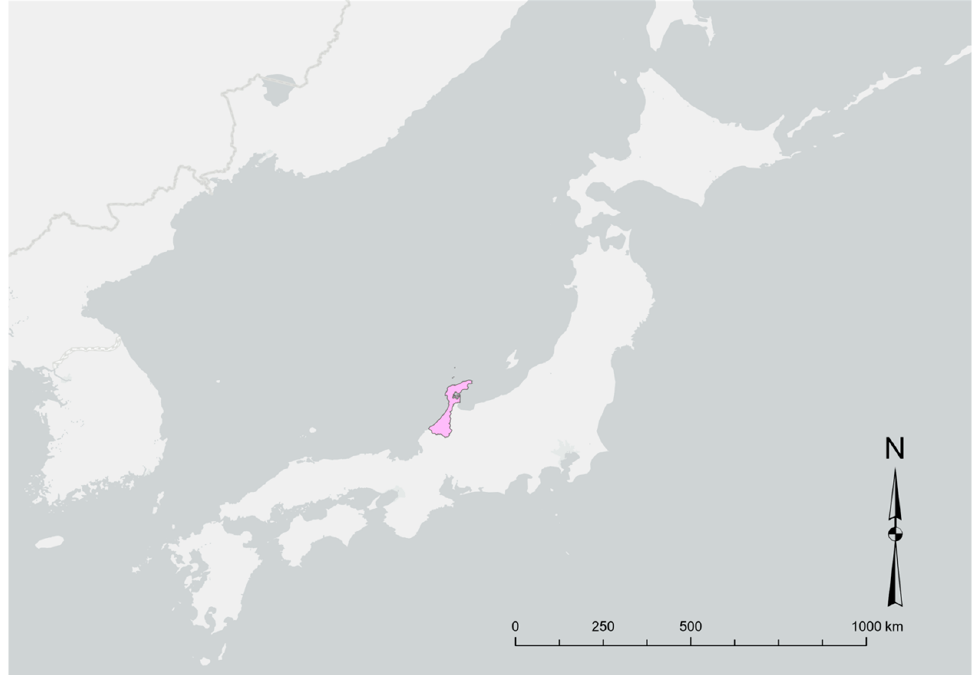
Figure 1. Location of Ishikawa